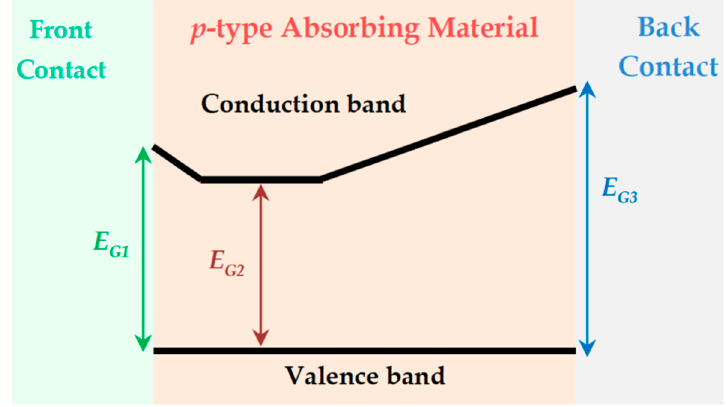
Figure 4. Band diagram of an optimized Ga double ‐ graded CIGS absorber material [9].